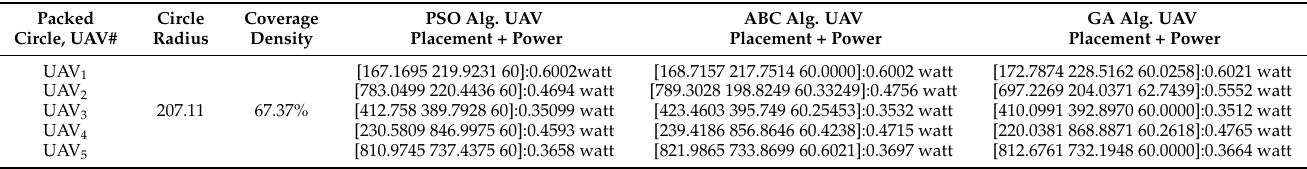
Table 4. Simulation results of the CPT-based benchmarker algorithm for uniform distribution